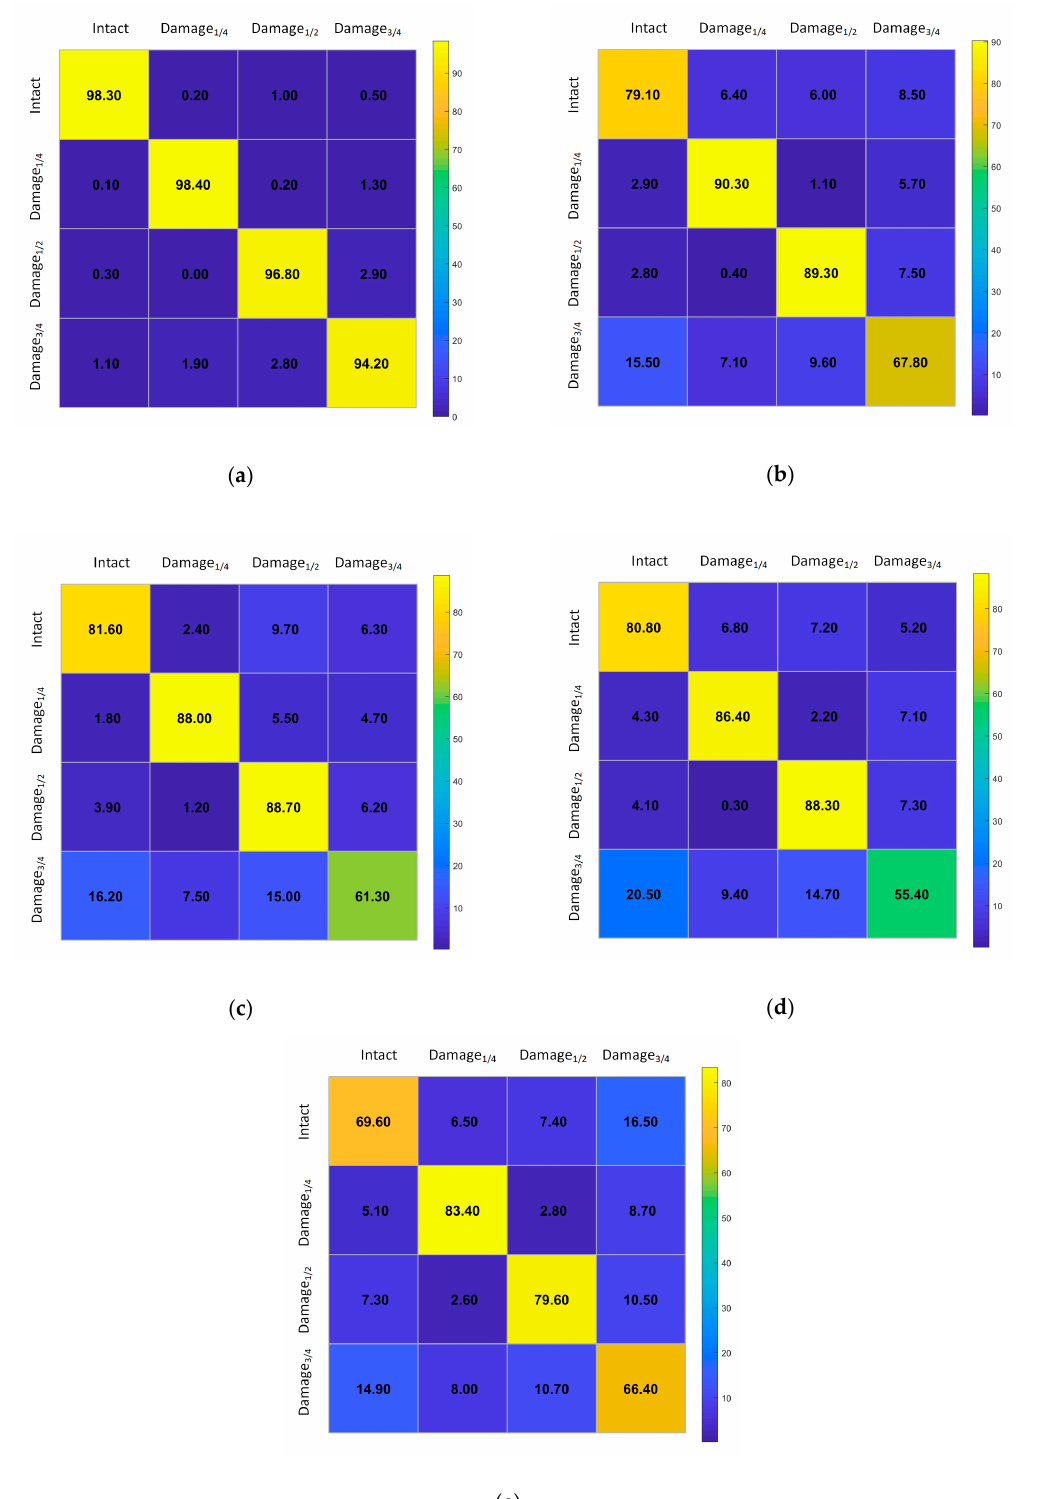
Figure 10. The confusion matrices of ( a ) CNN, ( b ) random forest, ( c ) support vector machine, ( d ) k-nearest neighbor, and ( e ) decision trees.